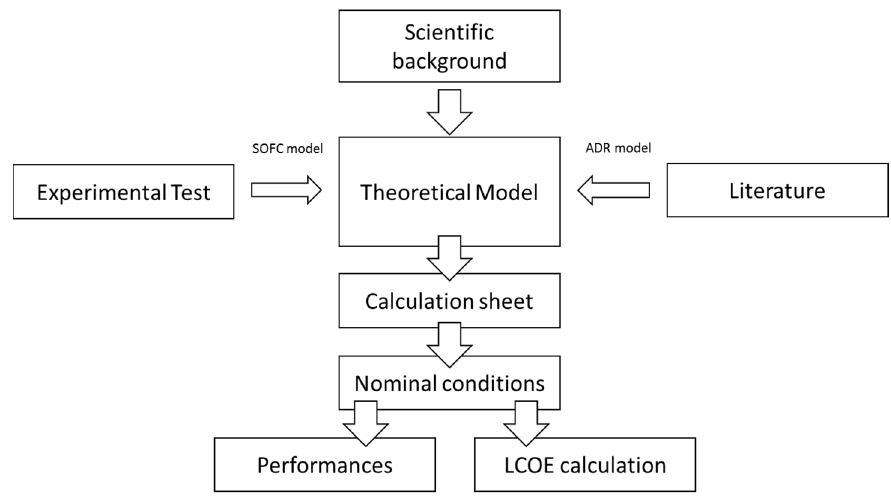
Figure 1. Schematic of the methodological workflow.